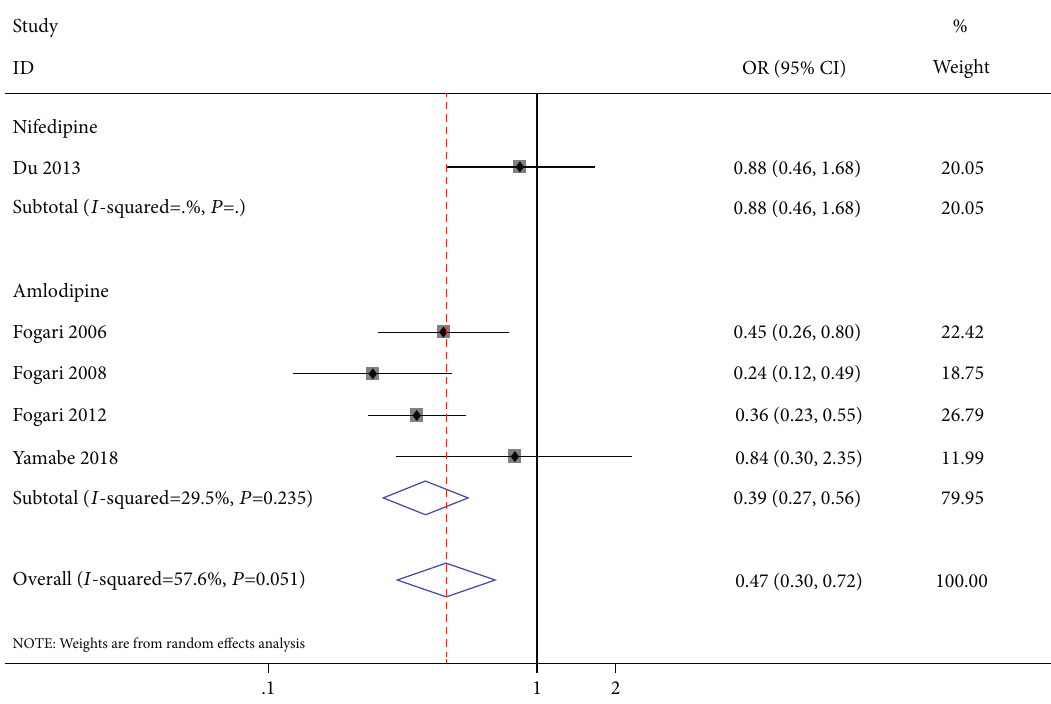
Figure 6: Forrest plot of subgroup analysis with the nifedipine group and amlodipine group in AF recurrence among patients with hypertension and